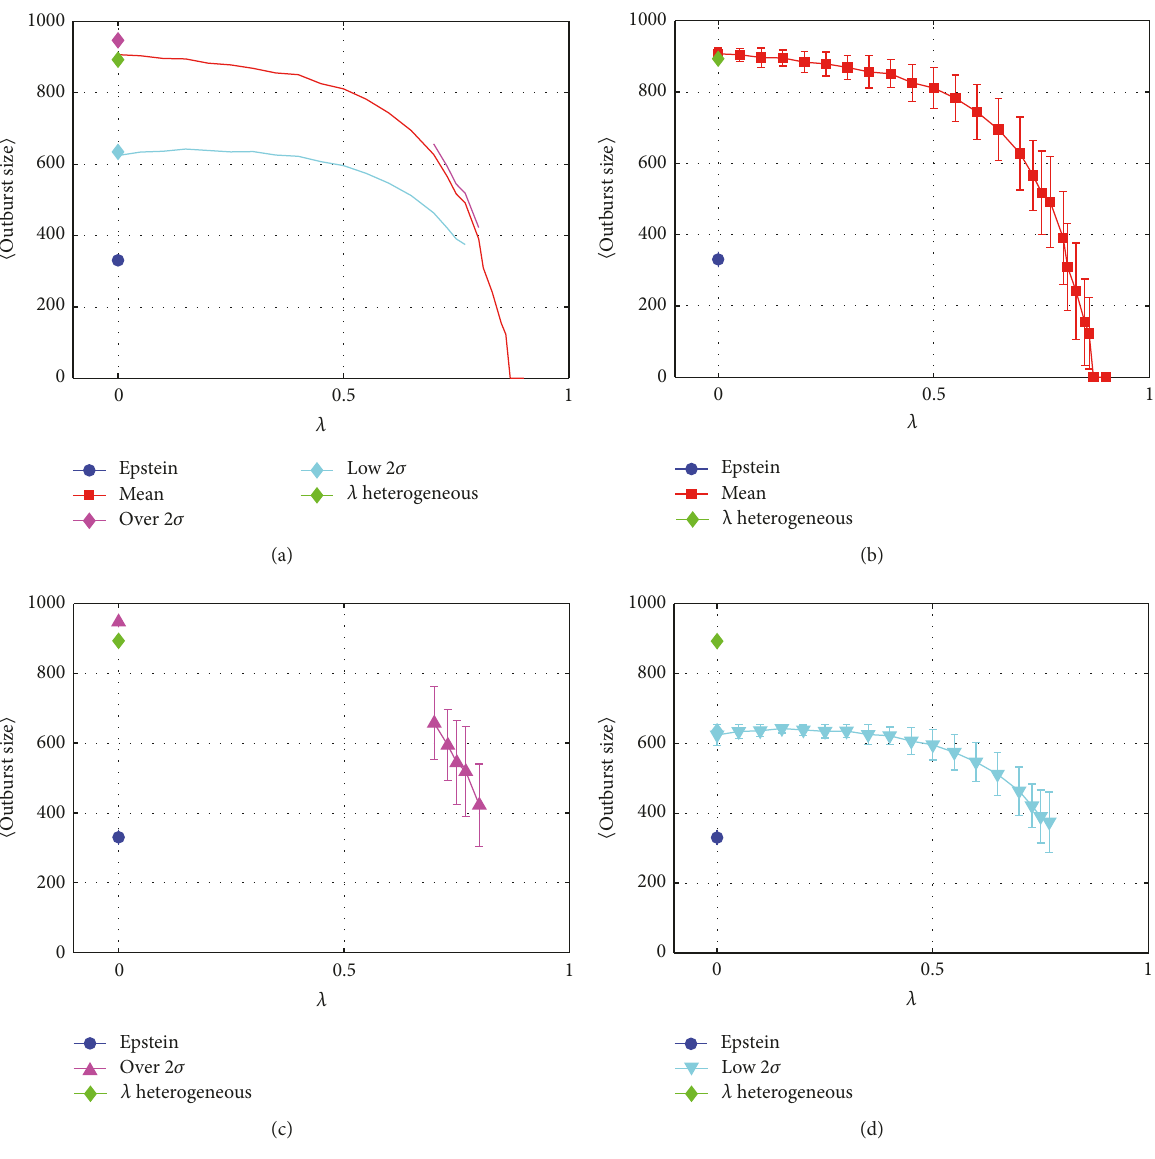
Figure 5: (a) The outburst size is plotted against the savings. The lines with red squares show the average value of the size of the outburst in the range [−2𝜎 𝜆 , 2𝜎 𝜆 ] ,where 𝜎 𝜆 isthestandarddeviationofthemaximumvaluesoftheoutburstsizesforeachlambdavalue.Themagentaandcyan lines show the average value of the size of the outbursts above and below the range [−2𝜎 𝜆 ,2𝜎 𝜆 ] , respectively. The blue circle corresponds to the average size of the outbursts obtained for the Epstein model and the diamond the average size of the outbursts obtained with heterogeneous lambda. In panels (b), (c), and (d), the average value of the size of the outbursts with their corresponding error bars, obtained both in the range [−2𝜎 𝜆 , 2𝜎 𝜆 ] and over and under the range,